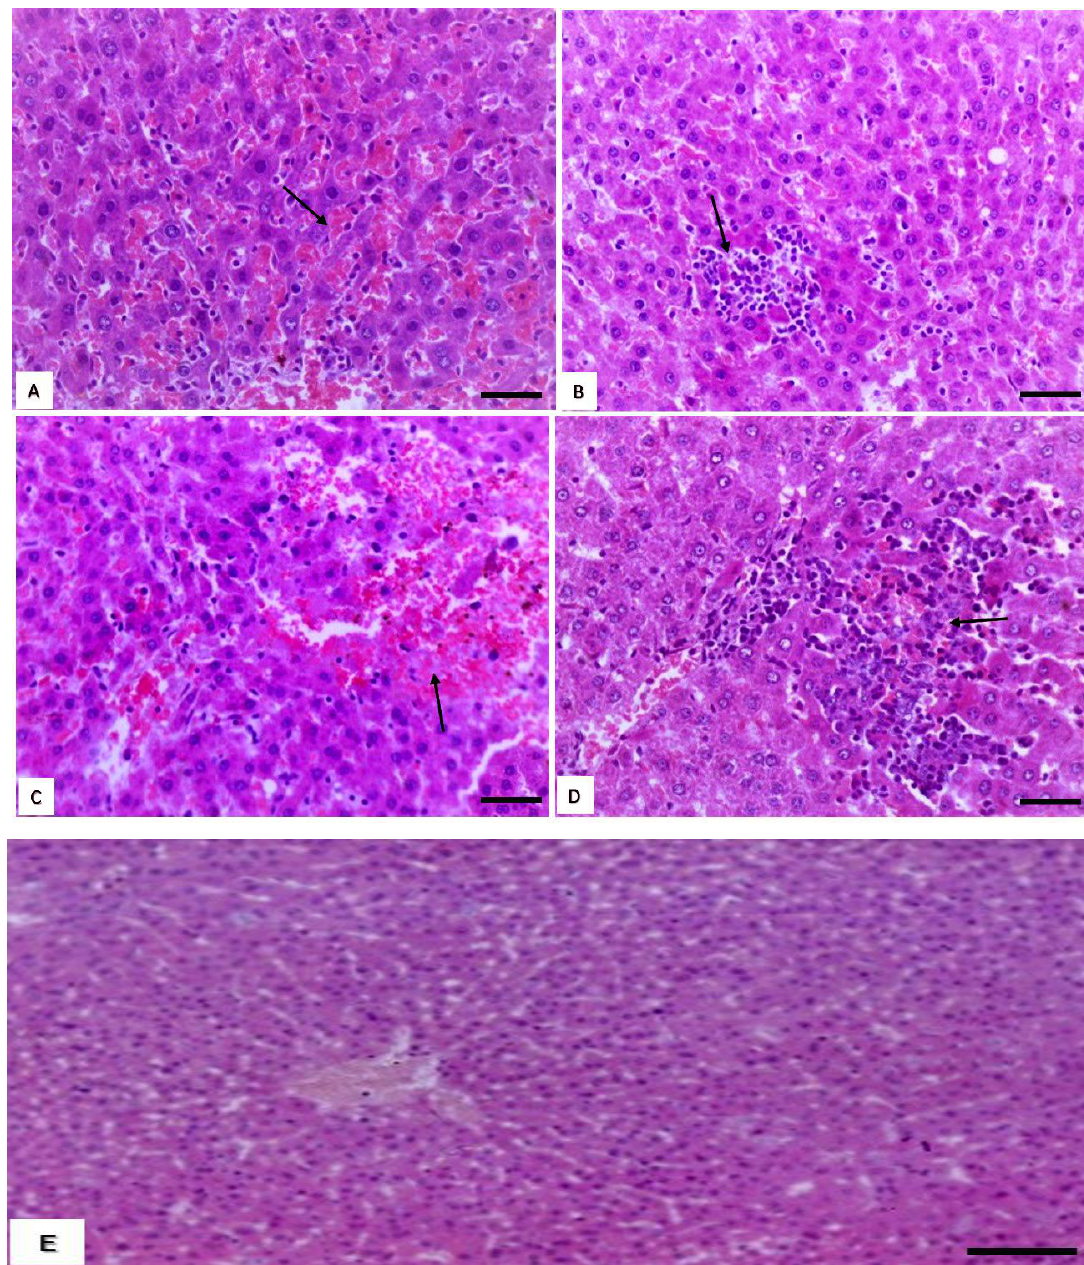
Figure 1. Effect of cymoxanil on the liver. ( A ) Liver of rat treated with low and medium dose showing congestion (arrow) and dilation of the hepatic sinusoids (H&E, bar = 50 µm). ( B ) Liver of rats treated with low and medium dose showing focal hepatocytic necrosis (arrow) with moderate infiltration of mononuclear cells (H&E, bar = 50 µm). ( C ) Liver of rats treated with high dose showing hemorrhages (arrow) (H&E, bar = 50 µm). ( D ) Liver of rats treated with high dose showing extensive piecemeal necrosis (arrow) with infiltration of mononuclear cells within and at the margin of the necrosed areas (H&E, bar = 50 µm). ( E ) Liver of control rats showing hepatic sinusoids in between hepatic cords and they are arranged around central vein (H&E, bar = 50 µm).